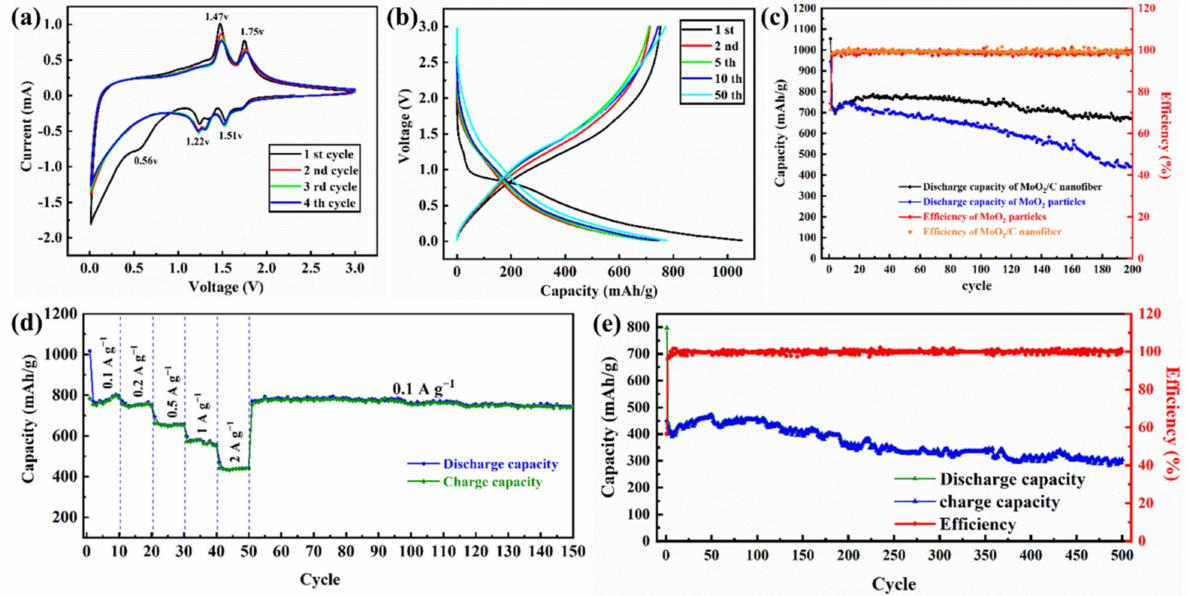
Figure 6. Cyclic voltammetry curves of MoO 2 /C nanofibers at 0.1 mV s − 1 ( a ); discharge/charge curves of MoO 2 /C nanofibers at 200 mA g − 1 ( b ); cycling performance and corresponding coulombic efficiency of the MoO 2 /C nanofibers and MoO 2 nanoparticle at 200 mA g − 1 ( c ); rate performance of the MoO 2 /C nanofibers at different current densities in the potential range of 0.01–3.0 V ( d ); cycling performance and corresponding coulombic efficiency of the MoO 2 /C nanofibers at 2000 mA g − 1 ( e